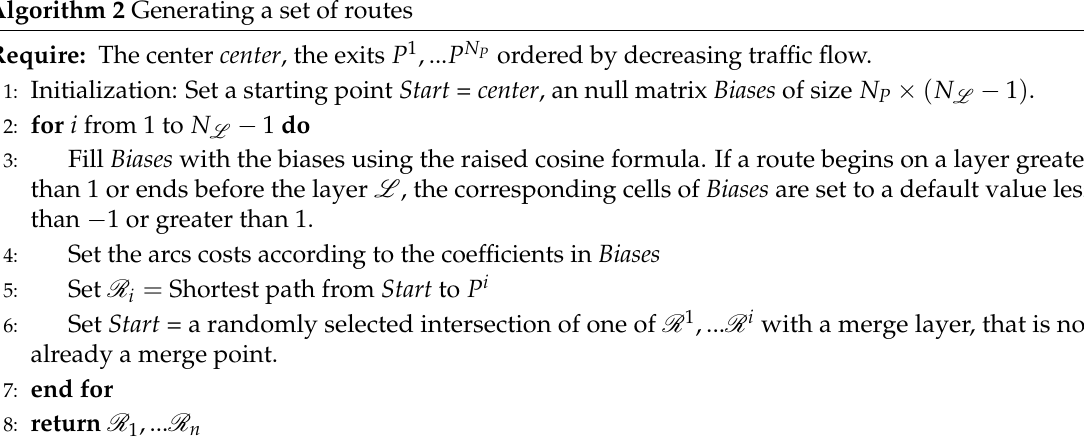
Algorithm 2 Generating a set of